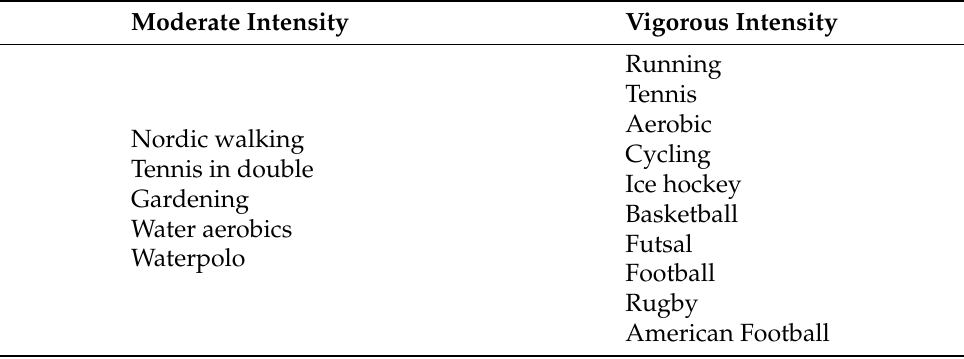
Table 2. Moderate and vigorous intensity